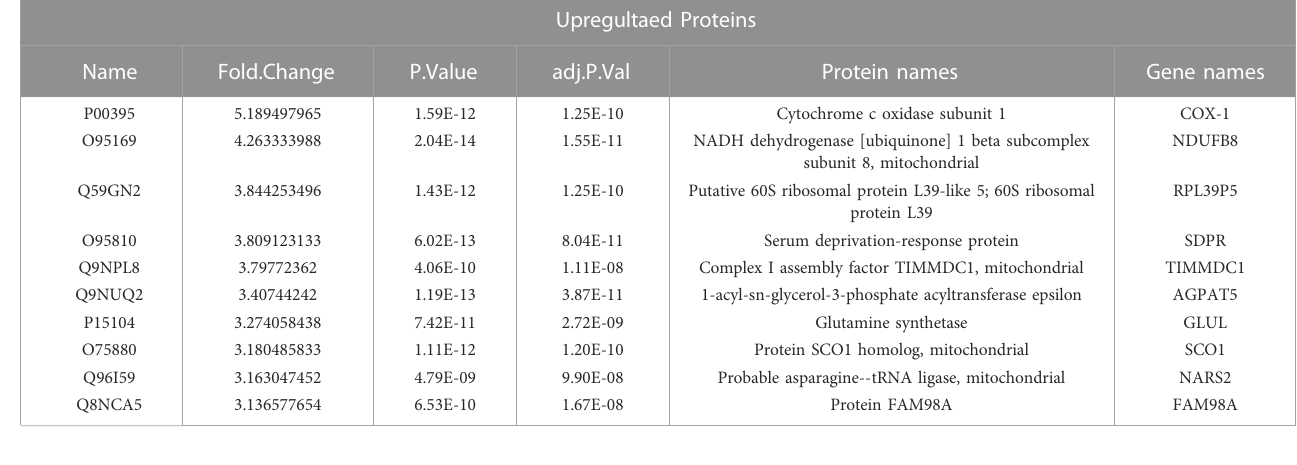
TABLE 1 Top ten upregulated DEPs from proteomics analysis.